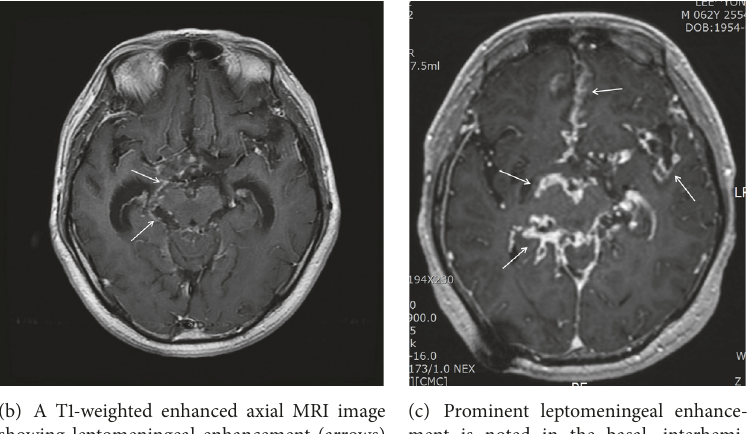
in the basal cisterns